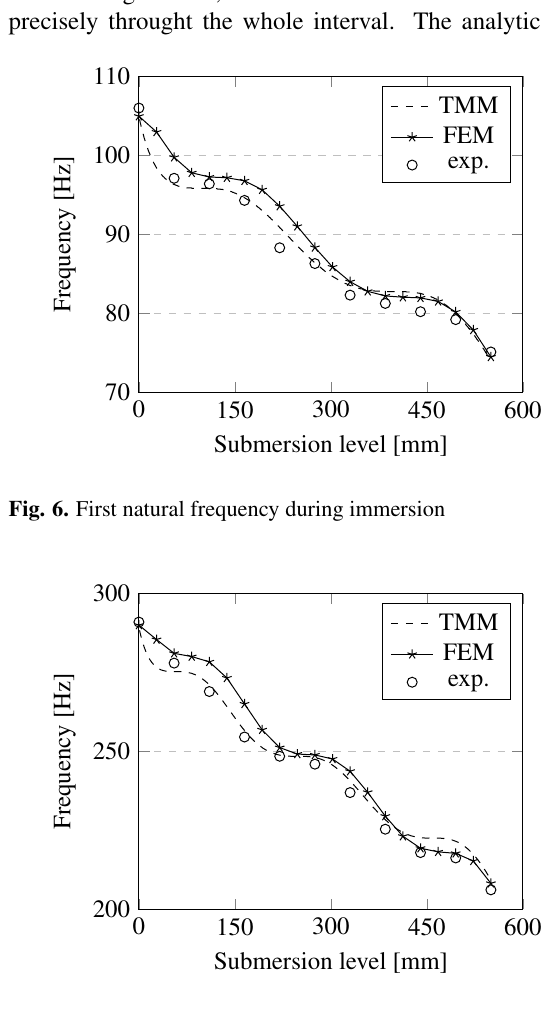
Fig. 7. Second natural frequency during immersion